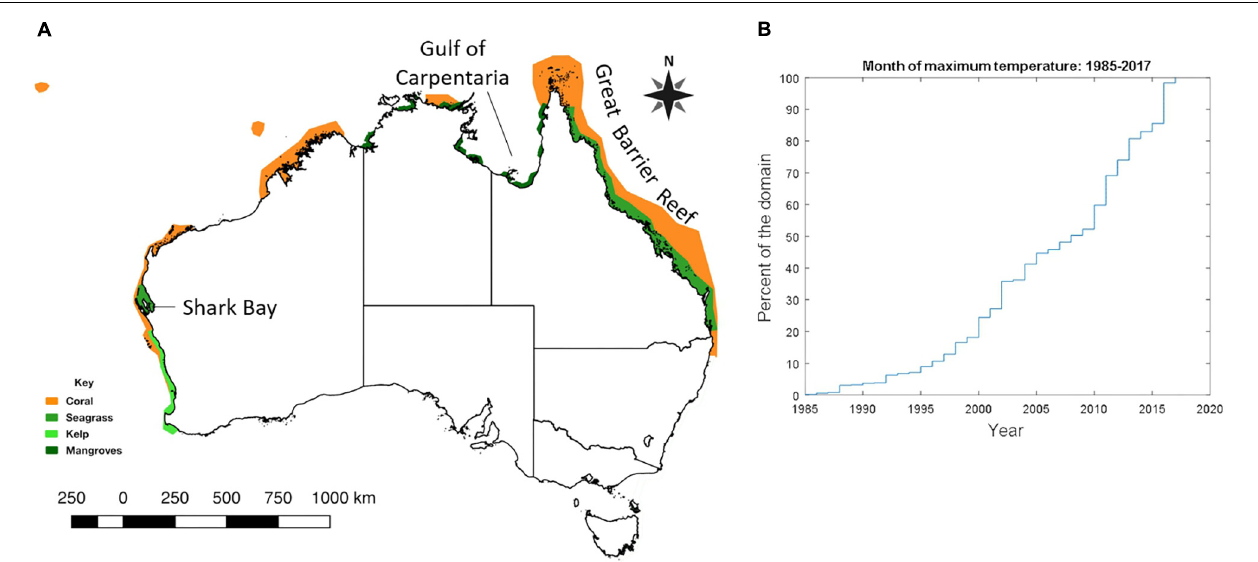
FIGURE 1 | (A) Cumulative habitat impact map (created by overlaying the individual event maps detailed in Figure 2 ). (B) Cumulative percentage of the Australian marine domain that experienced the maximum monthly SST for the period between 1985 and 2017, based on NOAA High Resolution Daily Sea Surface Temperature. The analysis was performed for each 0.25 × 0.25 degree cell in the domain (10–45 ◦ S, 110–160 ◦ E) for the period 1985–2017. The year in which the warmest month was recorded for each cell. The plot is the cumulative sum of these warmest years across all cells. For example, 50% of the ocean around Australia has experienced its warmest month between 2008 and